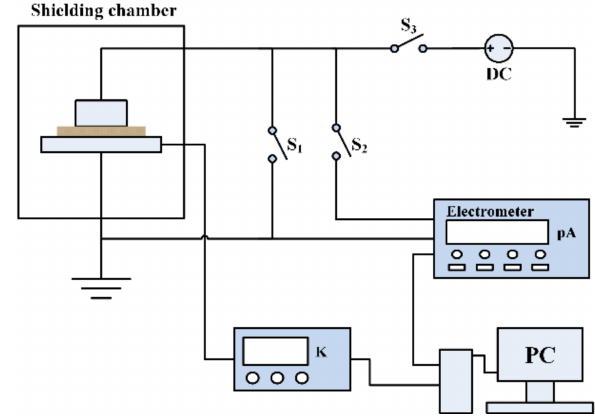
Figure 3. Schematic of experimental setup for measurement of thermally stimulated